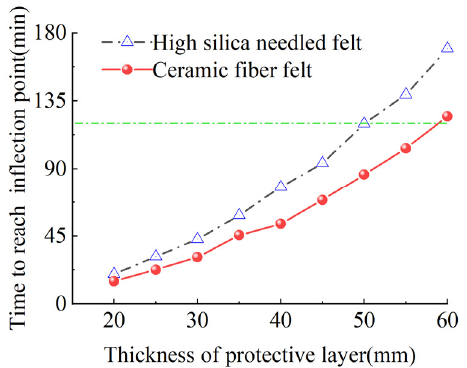
Figure 21. Time for heating rate to reach inflection point.